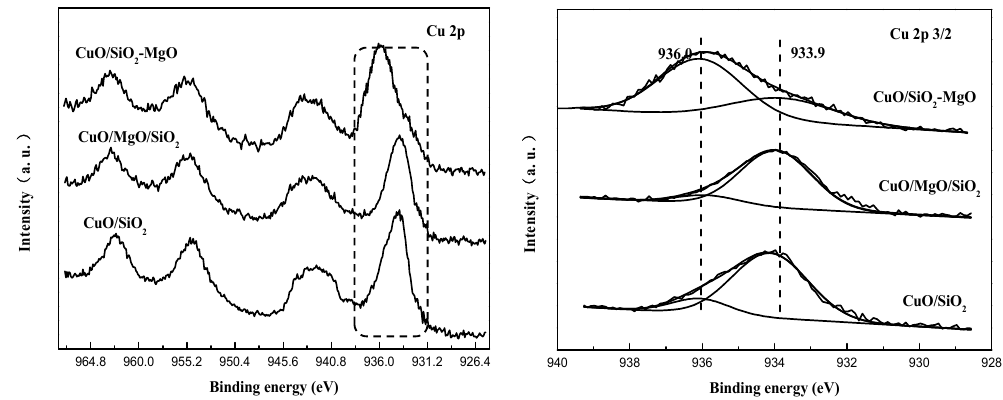
Figure 11. Cu 2p XPS spectra of the catalysts.